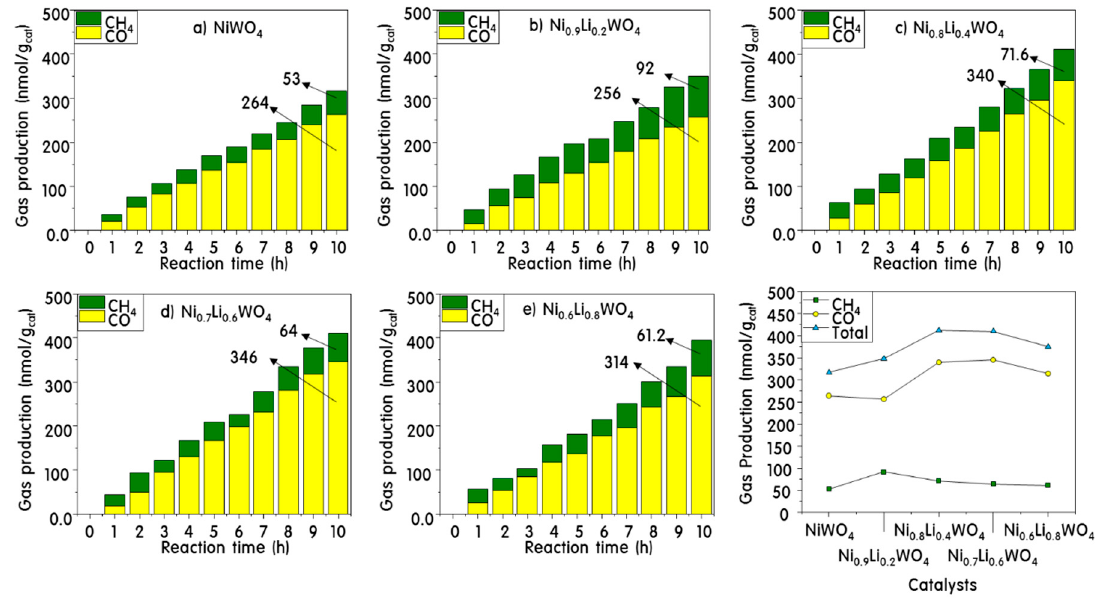
Figure 9. CH 4 and CO product distributions during CO 2 photoreduction over NiWO 4 ( a ) and Ni 1-x Li 2x WO 4 ( b–e ) catalysts.